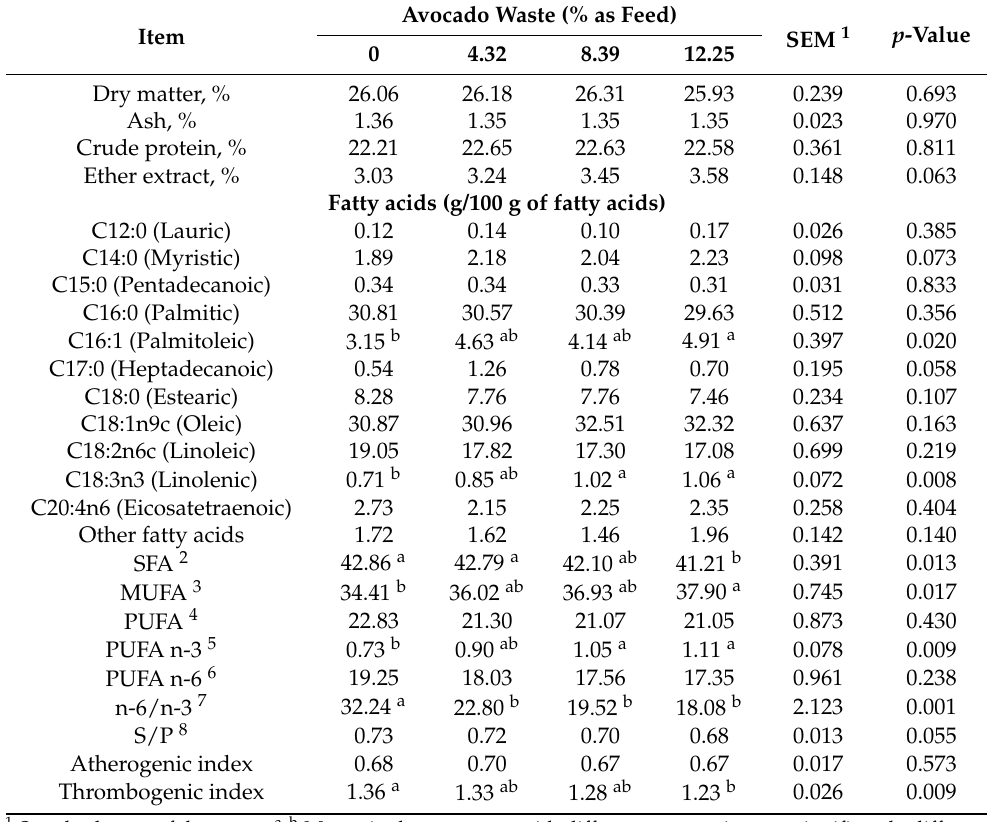
Table 5. Chemical composition (%) and fatty acid content (expressed as g/100 g of fatty acids) of Longissimus thoracis et lumborum muscle of fattening rabbits fed diets with different levels of avocado waste.